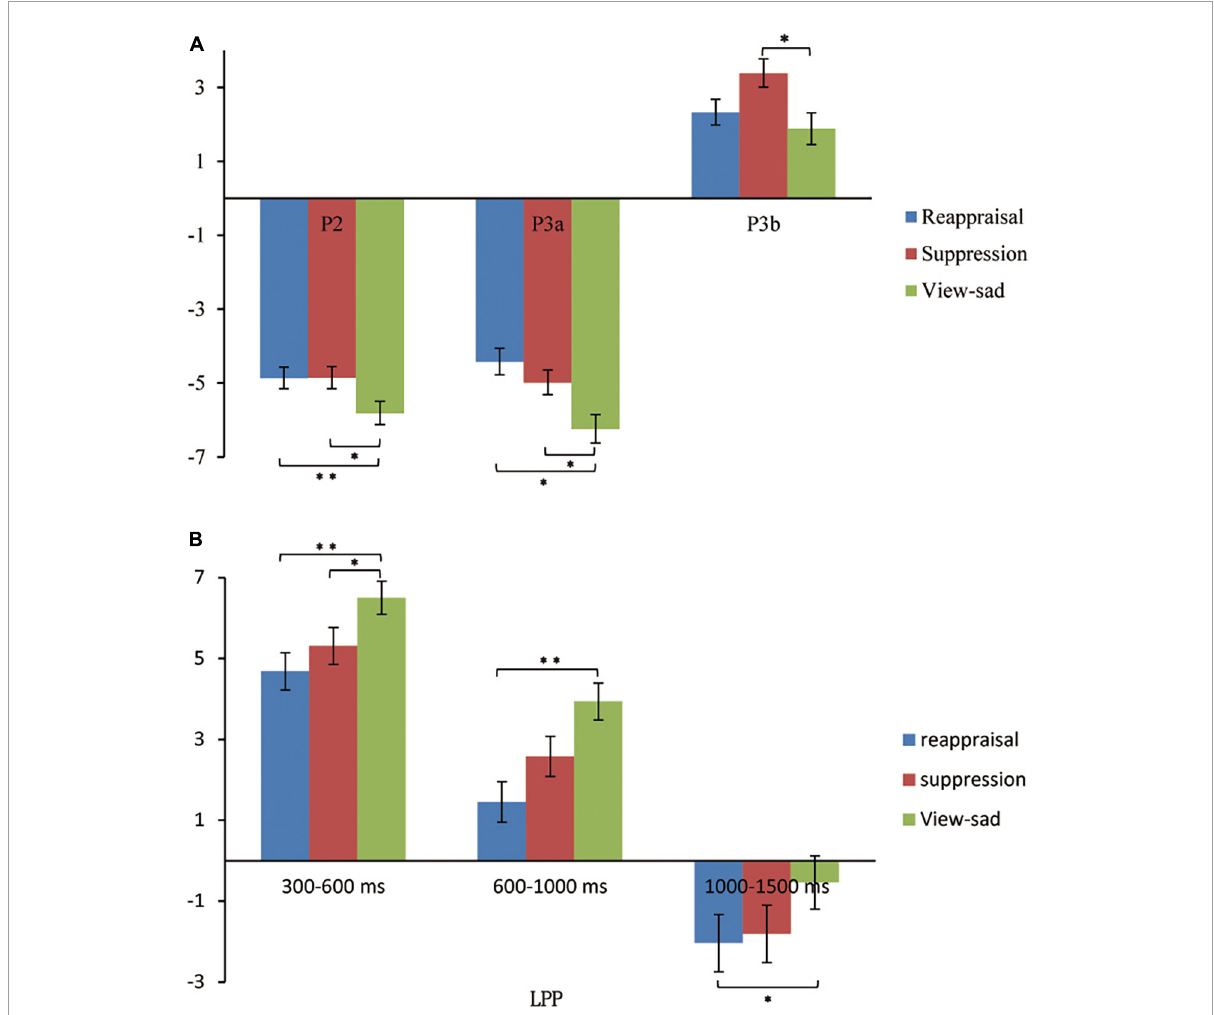
FIGURE5 The bar graphs about the differences between the conditions for each ERPS component. (A) The graph shows the differences between conditions for P2, P3a, and P3b components. (B) The graph shows the differences between conditions for LPP component during 300–600 ms, 600–1,000 ms, and 1,000–1,500 ms. ∗ p < 0.05, ∗∗ p < 0.01, ∗∗∗ p <